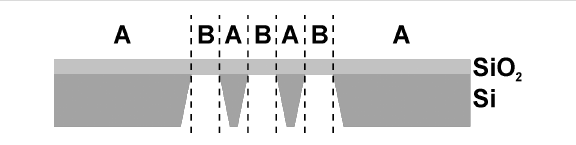
Figure 1: Schematic drawing of used membranes with 100 μ m thick Si grid and a 40 nm layer of electron-transparent SiO 2 .